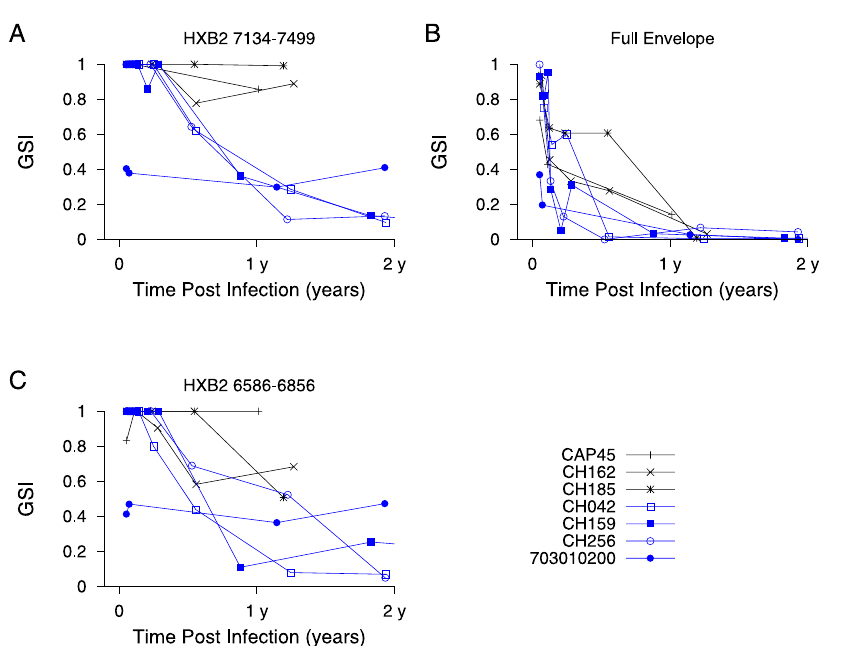
Figure 5. GSI dynamics in slow and fast decay groups. GSI dynamics of envelope gene segment HXB2 7134- 7499 ( A ), full envelope gene ( B ), and envelope gene segment HXB2 6586-6856 ( C ) in slow (CAP45, CH162, and CH185) and fast (CH042, CH159, CH256, and 703010200)